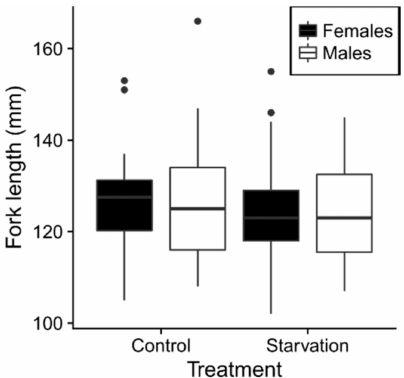
Figure 1. Tukey boxplots showing the distribution of fork length in recaptured fish of different sex from the different treatments. Boxes contain the second and third quartile of the data, separated by the median (horizontal line). Whiskers show the main spread of the data, and dots outside of the whiskers show data points >1.5 box-height away from the box.